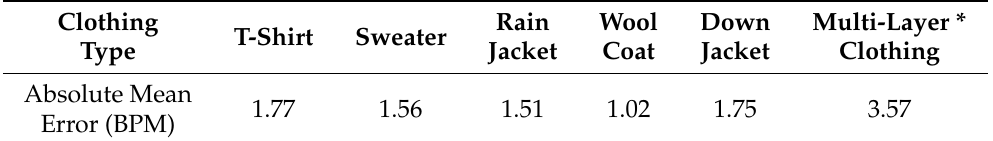
Figure 24. Types of clothes worn by participants in this study. Participants were asked to sit in a parked car with the engine running and breathe naturally during the measurements. Table 4. Absolute mean error of RR measurement when the participant is wearing different types of